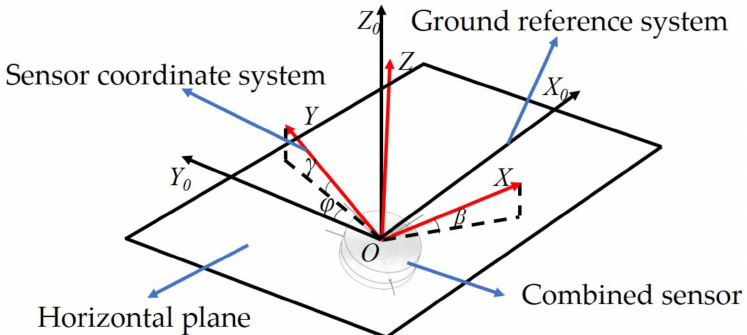
Figure 5. Diagram of the relationship between the sensor coordinate system and the ground reference system. The XYZ coordinate axis is the coordinate system of the combined sensor, and X 0 Y 0 Z 0 coordinate axis is the ground reference system. β , γ , ϕ are the pitch angle, roll angle, and heading angle,